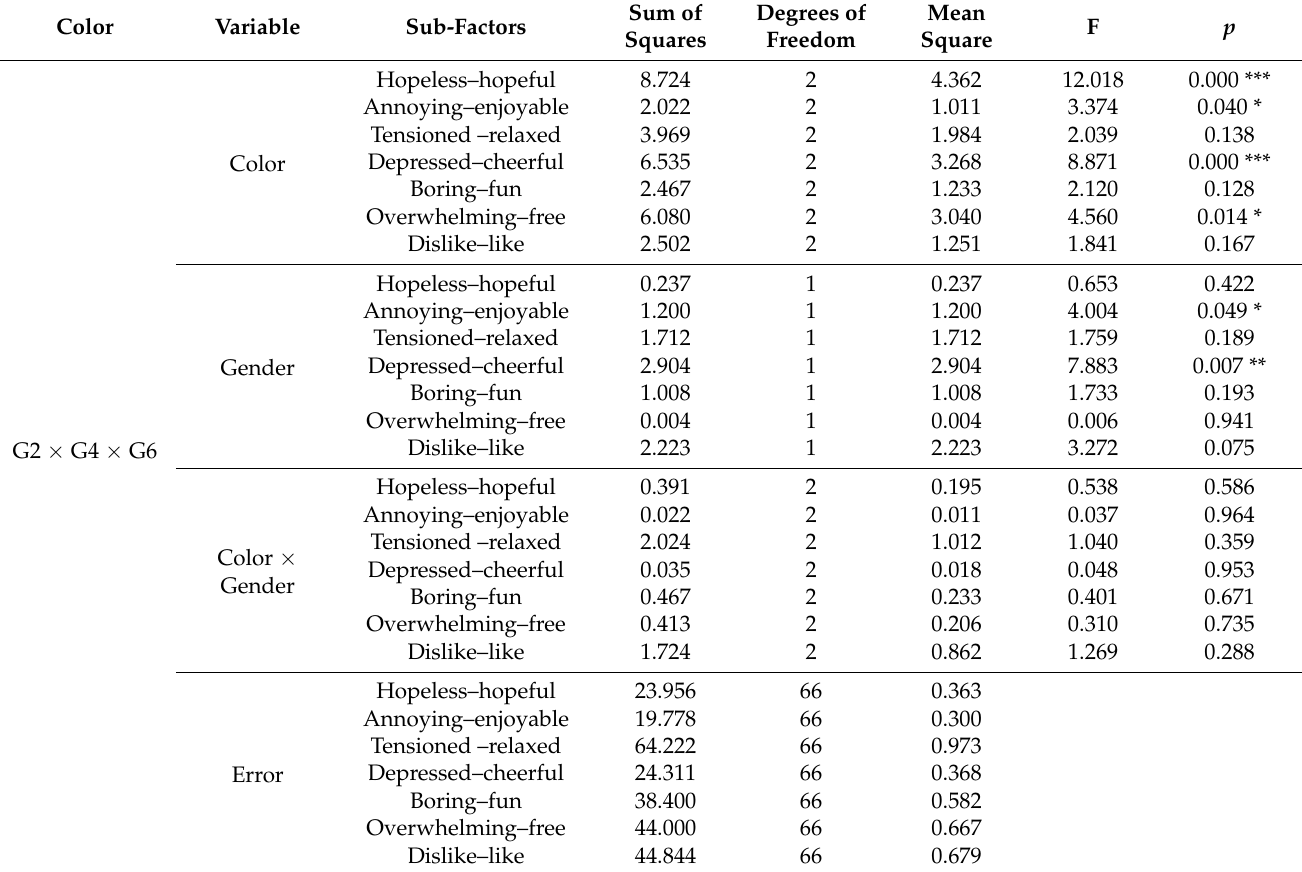
Table 11. Main and interaction effects of stress according to chroma changes under green hue and low-value